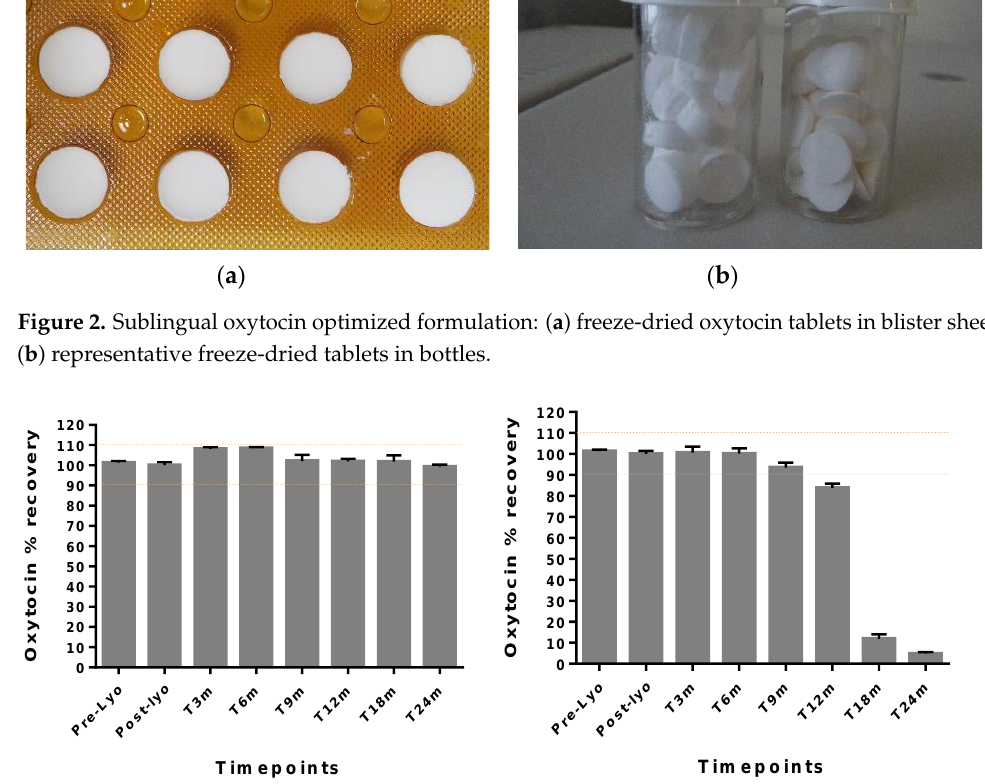
Figure 3. Stability data on heat-stable sublingual oxytocin tablets ( n = 2 per time point) stored at ( left ) 30 °C/65% relative humidity (RH) and ( right ) 40 °C/75% relative humidity (RH) for 24 months. The Y-axis shows recovery in oxytocin content from tablets undergoing stability evaluation under different storage conditions. The yellow dotted lines indicate oxytocin content maintained within 90 – 110%.